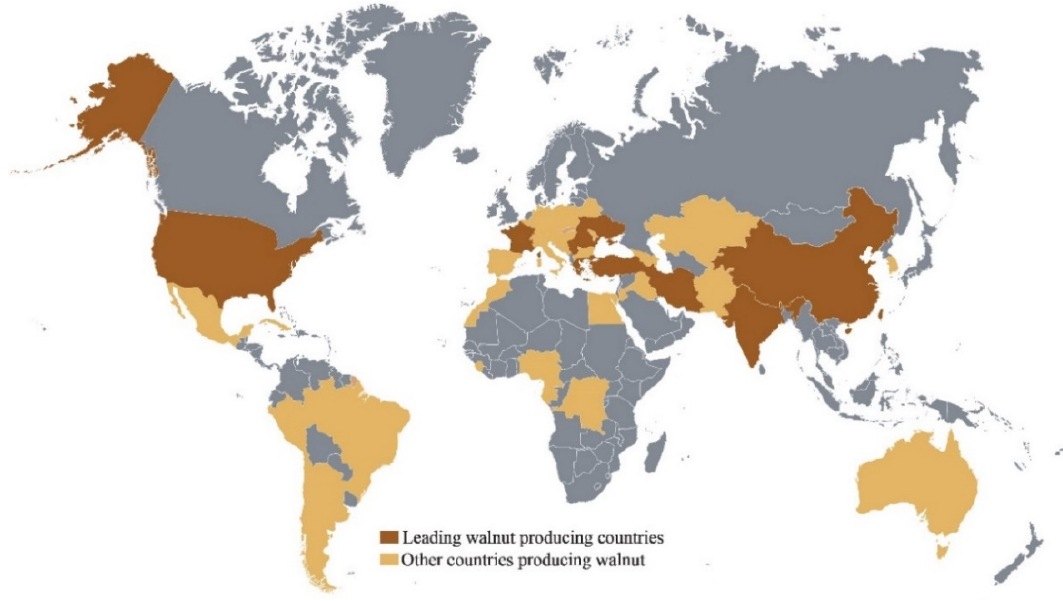
Figure 1. Global walnut-producing countries [4].